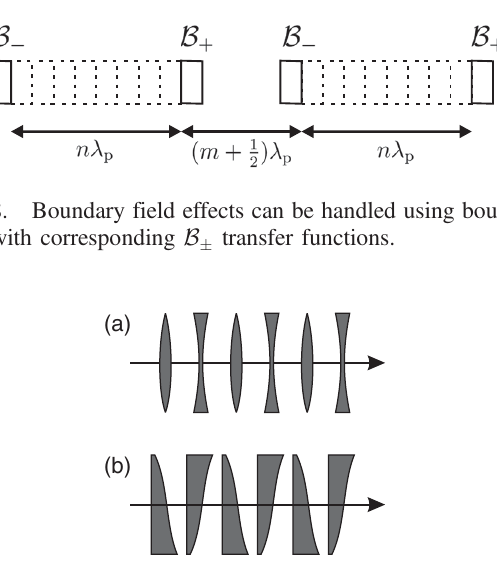
FIG. 9. Alternating lens (FODO) (a), and alternating nonlinear prisms (b), are examples of ponderomotive focusing